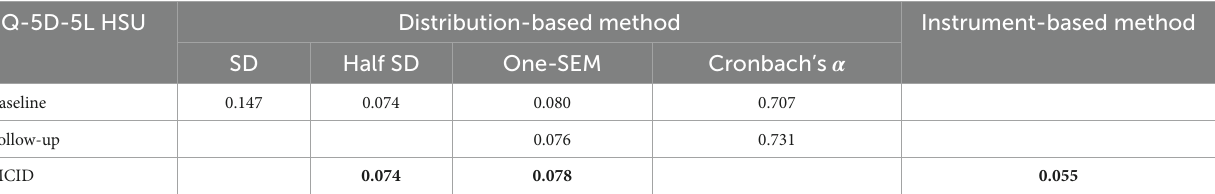
TABLE 6 Distribution-based and instrument-based MCID